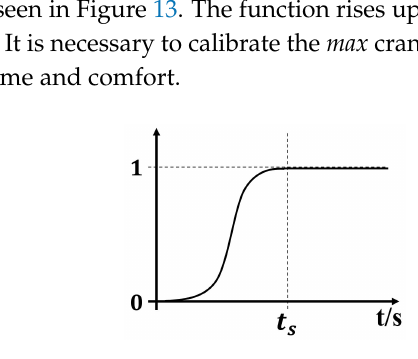
Figure 13. The regulation of function f 2 ( 0,1, t